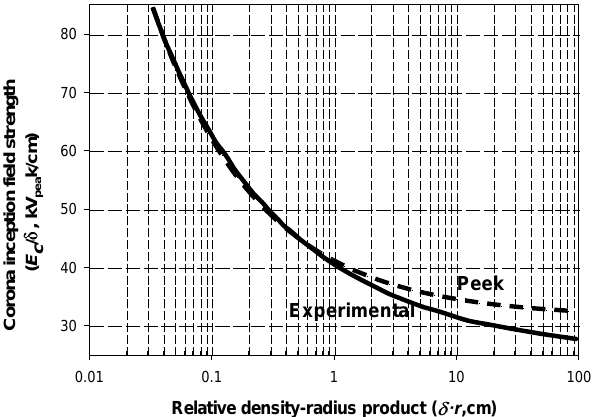
Figure 1. Corona inception field strength expressed as E c,peak /δ for coaxial cylinders electrodes with air insulation. Adapted from [48].